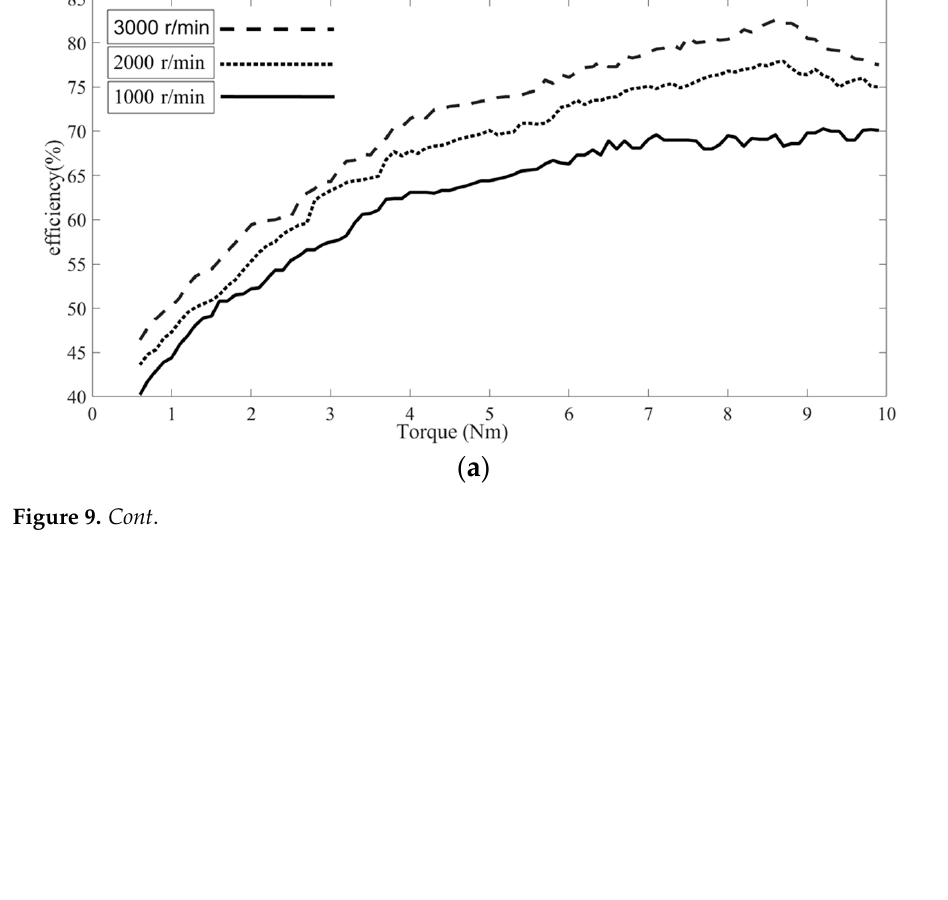
Figure 9. Efficiency test of different rotating speeds and shut-off angles. ( a ) Efficiency comparison of different rotating speeds when the turning off angle is 108°. ( b ) Efficiency comparison of dif- ferent rotating speeds with a turning-off angle of 129°. (2) Comparative test of different cut-off angles at the same speed Figure 10 shows the efficiency test comparison curve with the speed of 2000 r/min and 3000 r/min, respectively, the off angle of 108°, 129° and the fixed freewheeling angle of 188°. It can be seen that at different speeds, the efficiency of the fixed freewheeling angle of 188° is the highest, which explains the effectiveness of the shut-off angle control based on the optimal freewheeling angle proposed in the text.